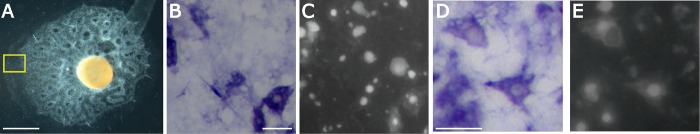
EmSFRP expression in amoeboid cells with filipodia in mesohyl at periphery of stage 5 sponge.A) Stage 5 juvenile sponge with functional aquiferous system. Scale: 1 mm. B&D) In situ hybridization of EmSFRP with staining in a subset of amoeboid cells with filipodia in the mesohyl of the pinacoderm. Multiple morphologies are shown, but all EmSFRP positive cells are amoeboid in shape. Region of sponge where photos were taken is shown in yellow box in A. C&E) Dapi staining of sections shown in B and D show locations of staining and not staining cells. Scales: 20 μM.